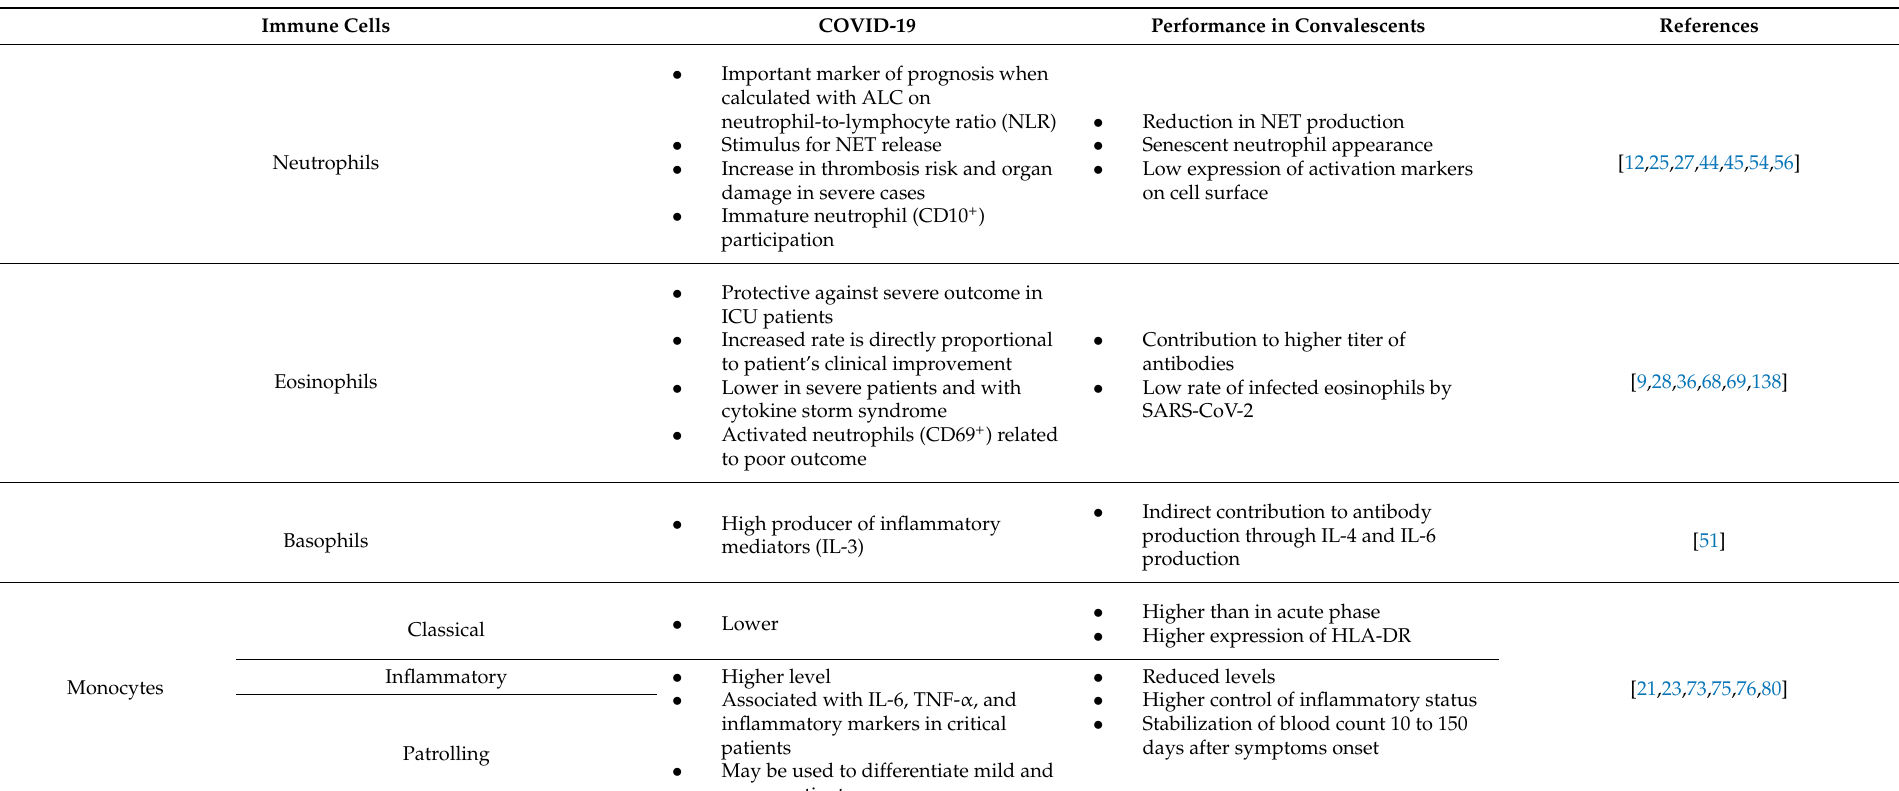
Table 1. Major functions of innate immune cells and their subtypes during COVID-19 disease and convalescence. Phenotypic and functional dynamics are described, which may contribute to laboratorial and clinical aspects of SARS-CoV-2 infection, as well as participation during